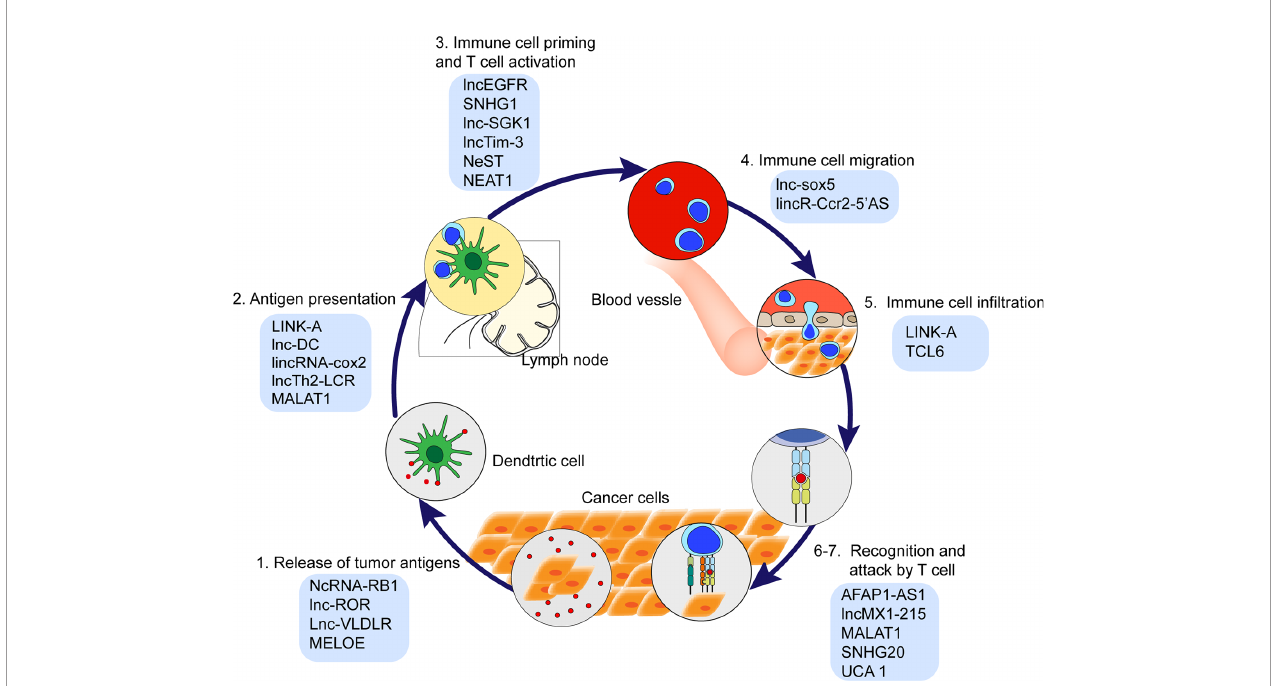
FIGURE 1 | The cancer immunity cycle and the lncRNAs involved in each step of cancer immunity